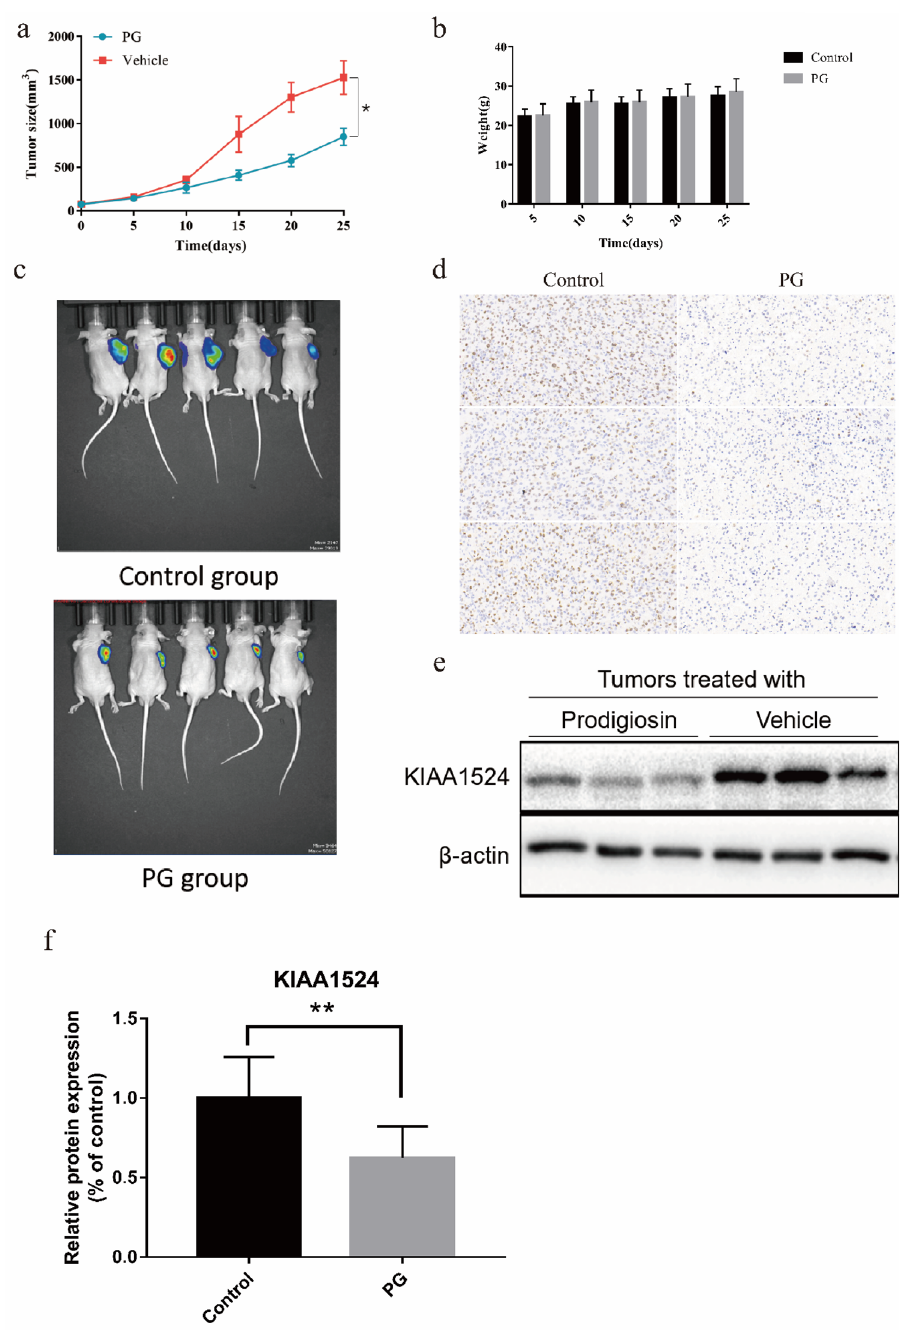
Figure 6. Antitumor effect of PG in the LN229 xenograft model. ( a ) The growth curves of LN229 xenograft tumors in PG and vehicle-treated nude mice: the size of tumors was measured by Vernier calipers every five days. Tumor volume calculation formula: Length × width × width/2. Data are expressed as the means ± SEM. p < 0.05. ( b ) Graphic representation of body weight. Data are expressed as the means ± SD. p < 0.05. ( c ) Bioluminescent signals in mice were detected immediately after injecting D-luciferin potassium salt (Day 25). ( d ) Immunohistochemistry staining of Ki67 in the tumor sections from control or PG group.( e ) The protein levels of KIAA1524 and β-actin in LN229 xenograft tumors were measured by western blotting. ( f ) Graphic representation of relative levels of protein expression in tumors. Data are expressed as the means ± SD. p <